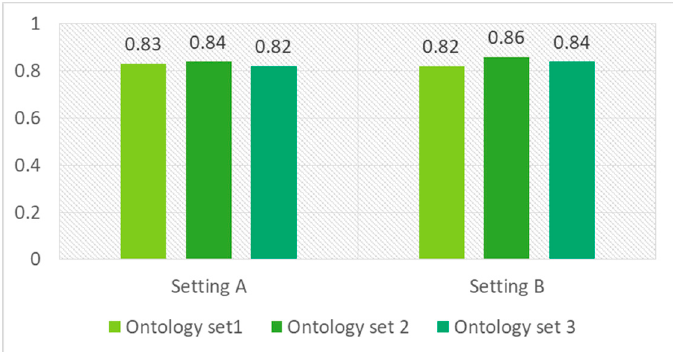
Figure 24. Semantic ontology alignment accuracy on external data.